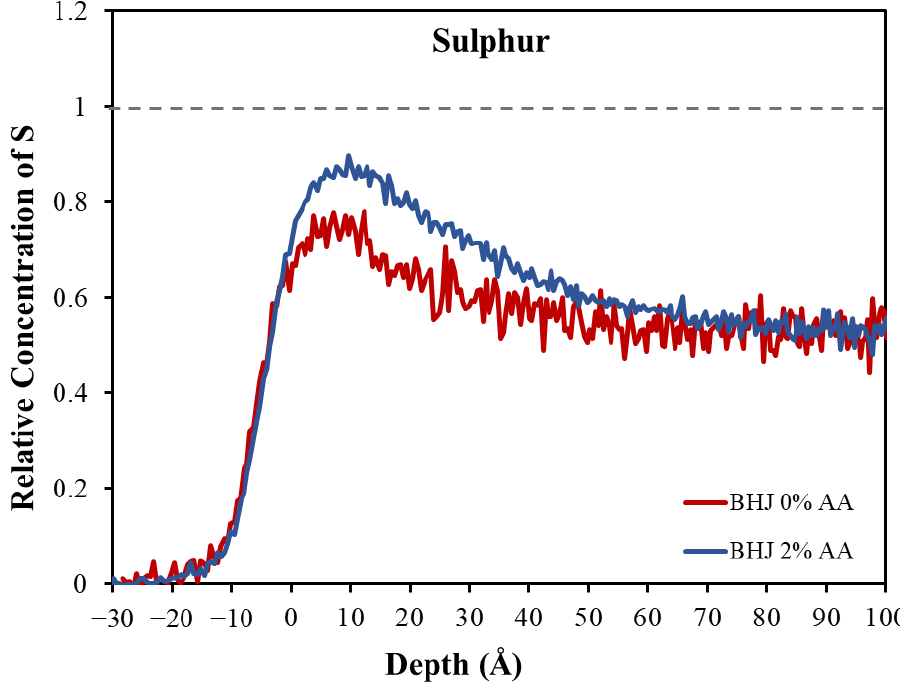
Figure 3. Comparing the concentration profiles of BHJ with 2% AA and without the additive. The dashed line indicates the bulk concentration of S for the ratio of 1:1.3 (the ratio of PTB7-Th: ITIC). The S to C ratio for the bulk in the spectrum of the BHJ can be determined from the elemental composition of the individual components.